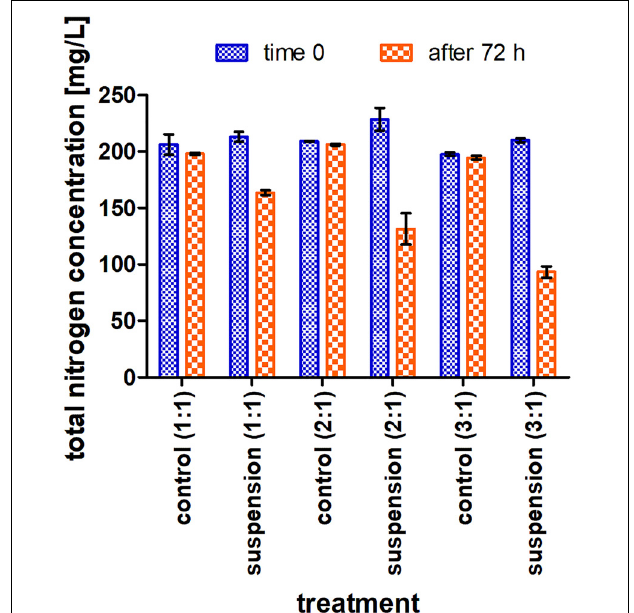
FIGURE 4 | Total nitrogen concentration at time 0 and at the end of the flask experiment, where the nitrogen source is nitrate at an initial concentration of 200 mg/l; treatment vs. sterile control at three different C:N ratios (1:1, 2:1, and 3:1). The data are means of three replicates + standard